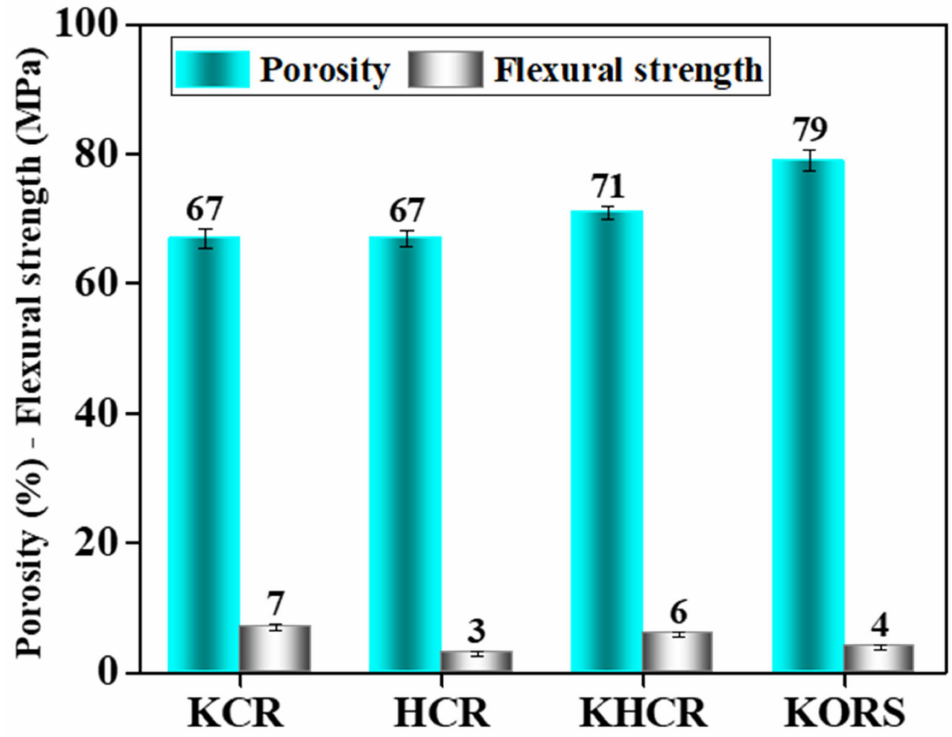
Figure 6. Biaxial flexural strength and porosity of manufactured green tapes (before